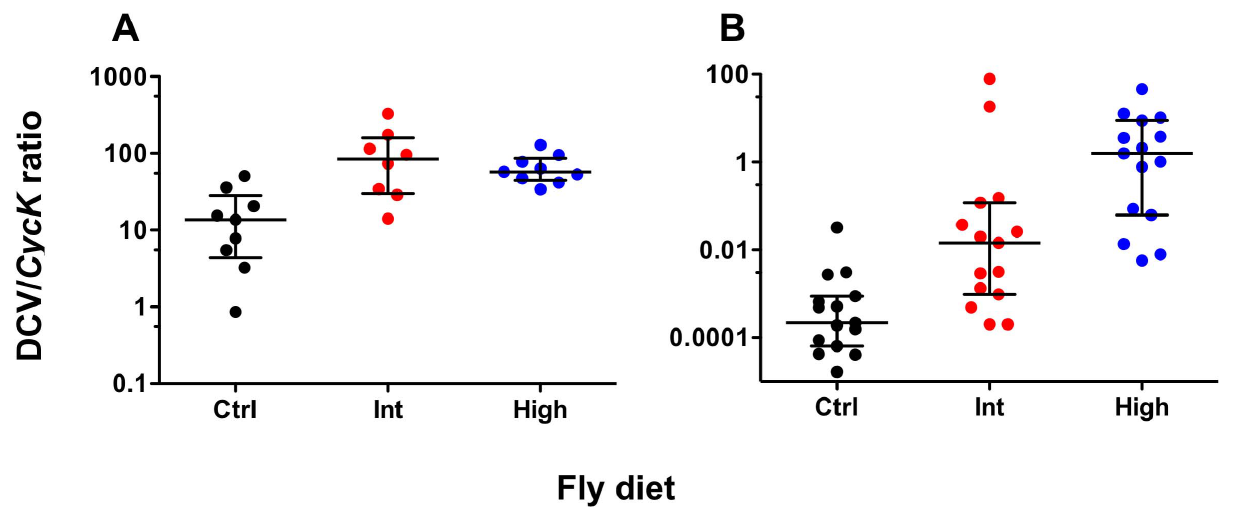
Figure 2. DCV levels of Wolbachia -infected flies fed cholesterol-enriched food. Mean normalised DCV: CycK expression ratios (median 6 interquartile range) for w MelPop- ( A ) and w MelCS-infected flies ( B ), five days-post DCV infection. Total DCV copies were quantified using qPCR and normalised against CycK expression levels. Data were compared statistically using Mann-Whitney U-tests. Both strains had higher DCV levels after rearing on the Intermediate (Int) and High (High) cholesterol-enriched diets than for Standard diet (Ctrl), this suggests that it is likely that rearing on high cholesterol diets increases the rate of viral accumulation.